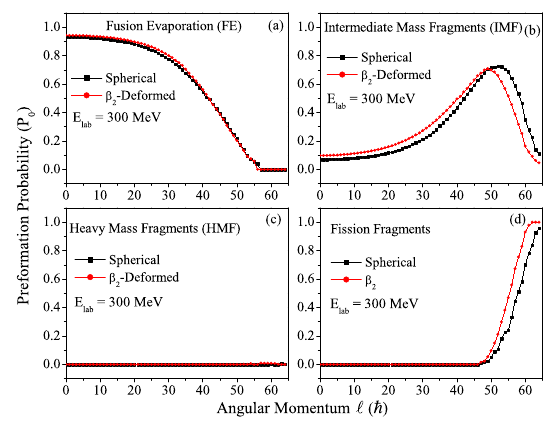
Figure 2. Summed up preformation probability of all possible decay modes: (a) FE, (b) IMF, (c) HMF, and (d) fission, varying as a function of angular momentum ( (cid:96) ) for both spherical and β 2 -deformed choice of fragments at E lab = 300MeV.